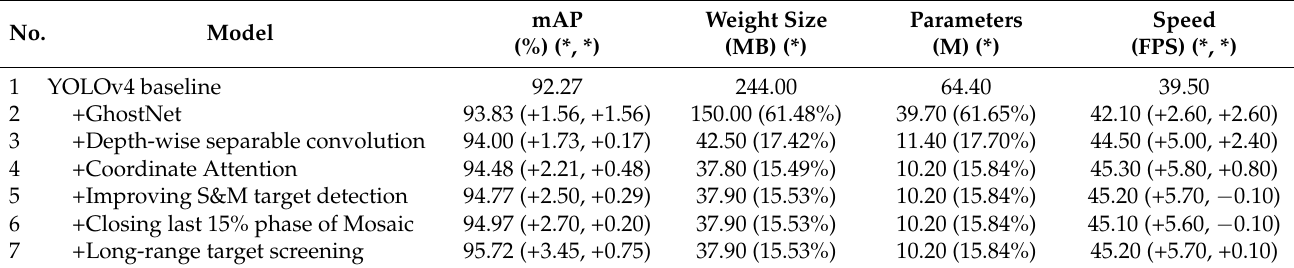
Table 3. Results of the ablation experiments on the test